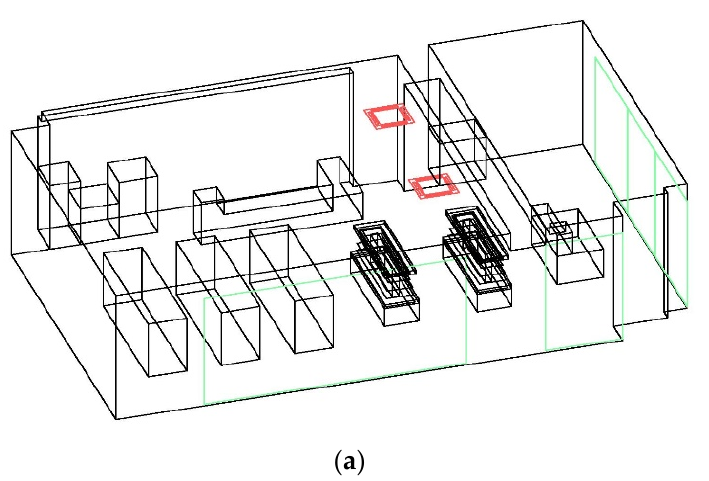
Figure 3. Geometry model; ( a ) convenience store; ( b ) CSS.